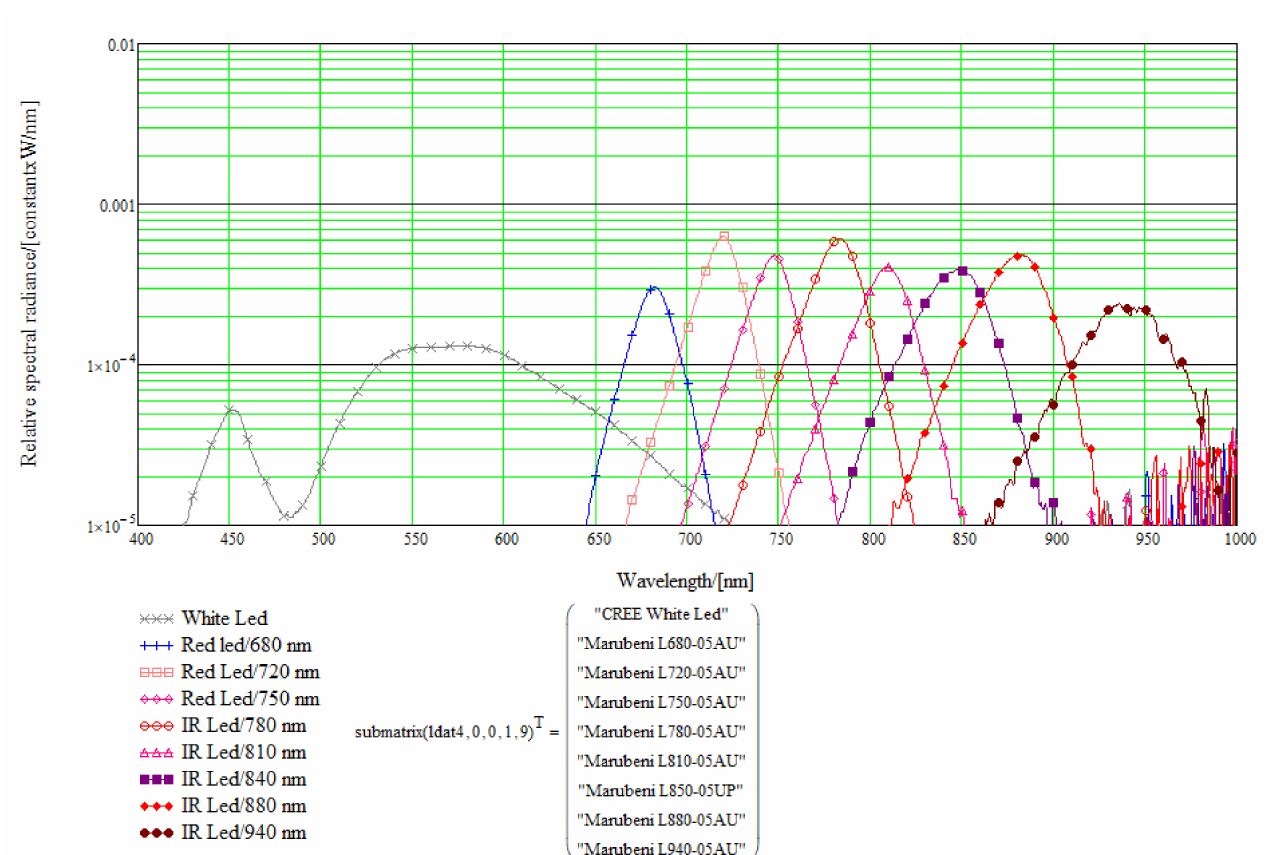
Figure 7. Results of the single LED spectral radiance measurements with the setup shown in Figure 6. The ma38 mA DC LED current was used for each LED. The distance of the target in this measurement was 50